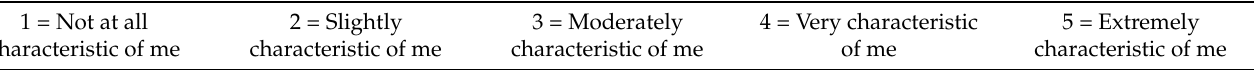
Table A1. Instructions: The following scale contains statements concerning your body physique or figure. By “physique” or “figure” we mean your body’s form and structure; specifically, body fat, muscular tone, and general body proportions. Read each item carefully and indicate how much each of them characterizes